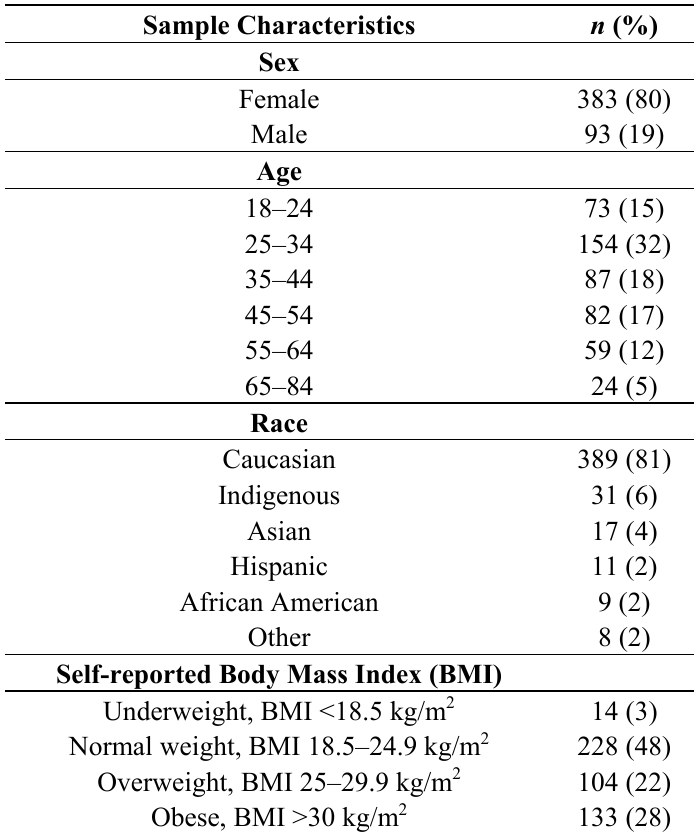
Table 2. Sample Characteristics ( n =